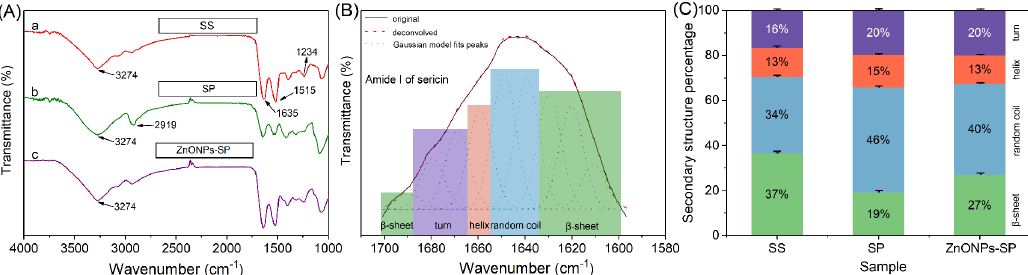
Figure 4. FTIR spectra and secondary structure analysis. ( A ) FTIR spectra of sericin (a), SP (b), ZnONPs-SP (c), ( B ) The curve-fitted spectrum of the amide I region of sericin, ( C ) The contents of different secondary structures in the sponges.